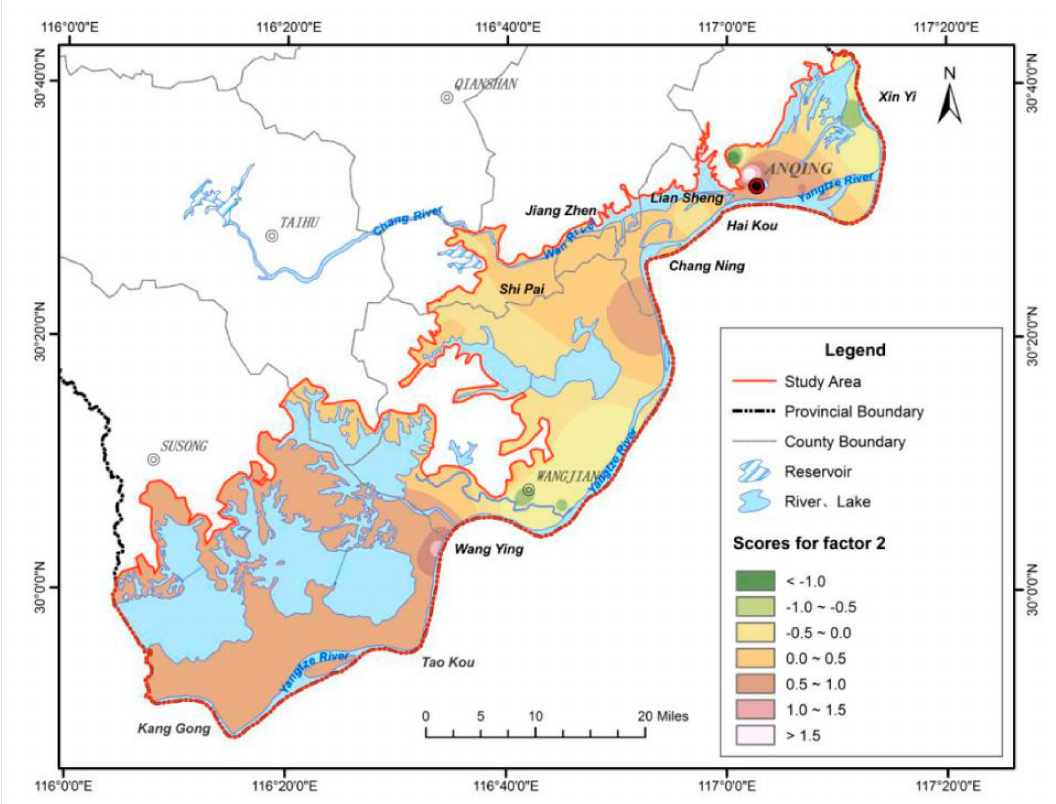
Figure 8. Distribution of scores of factor 3 for phreatic